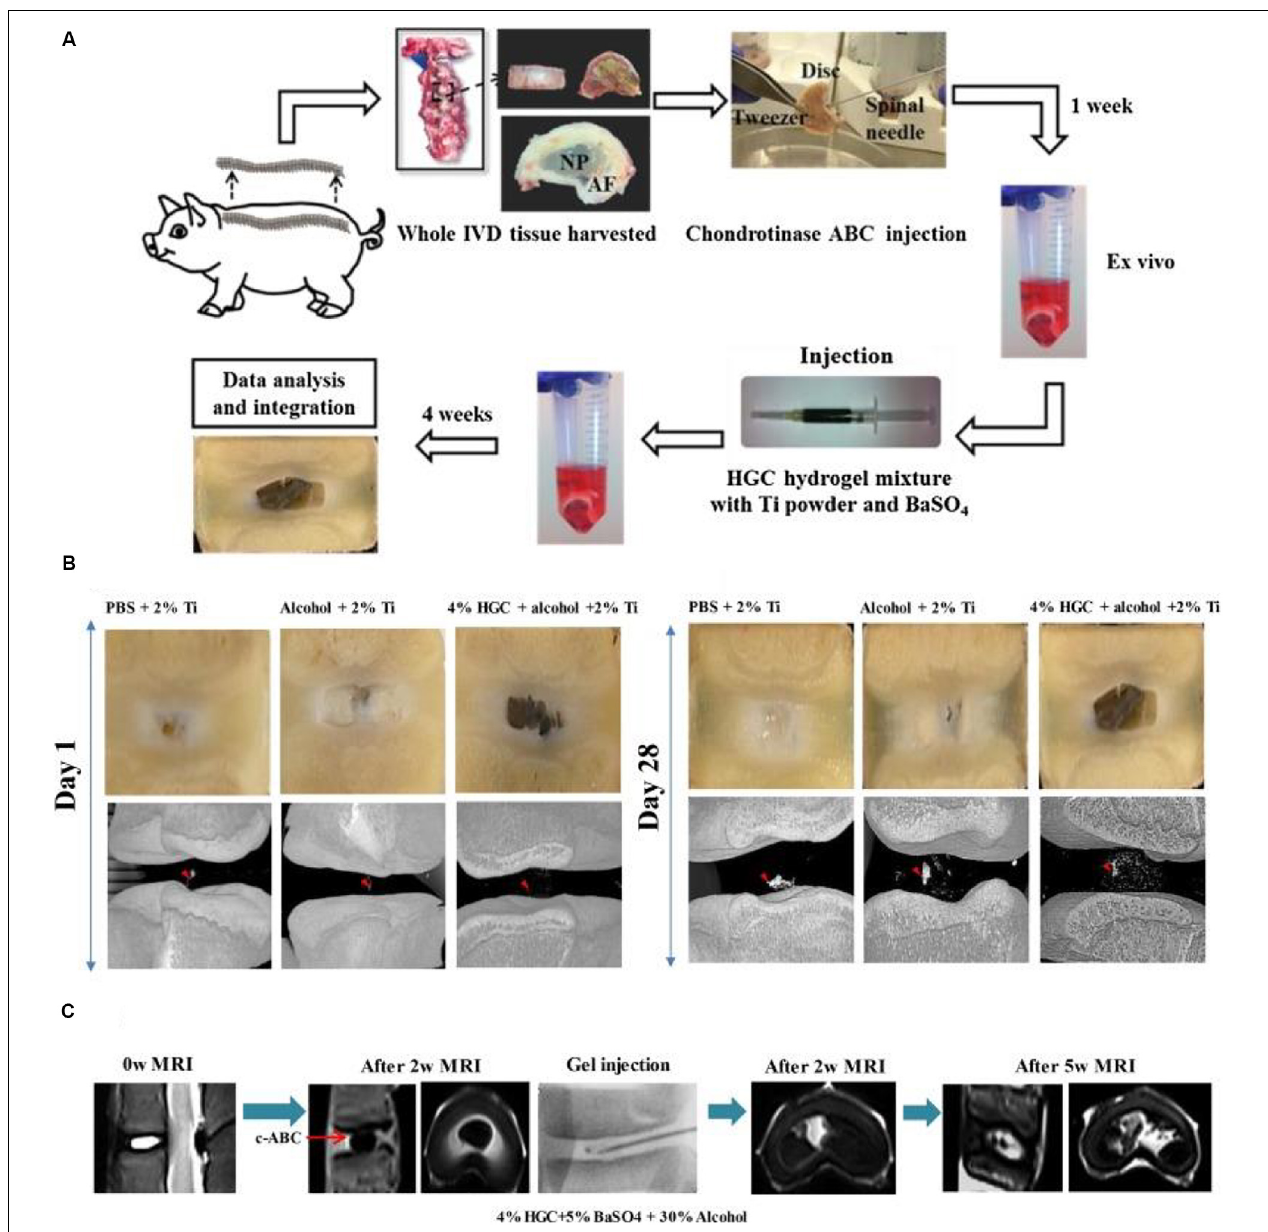
FIGURE 2 | (A) Schematic description of the evaluation of ex vivo degenerative IVD tissue and treatment with HGC hydrogel for CT and MRI imaging. (B) Macroscopic observation and micro-CT images of degenerated IVD tissue at 1 day and 28 days after injection with hydrogels. (C) MRI images of IVD tissue before and 2 weeks after the disk degeneration process and subsequent degenerative IVD tissue at 2 weeks and 5 weeks after injection of HGC hydrogel in 30% alcohol solution. Reproduced from Li et al. (2018) with permission from Copyright 2018